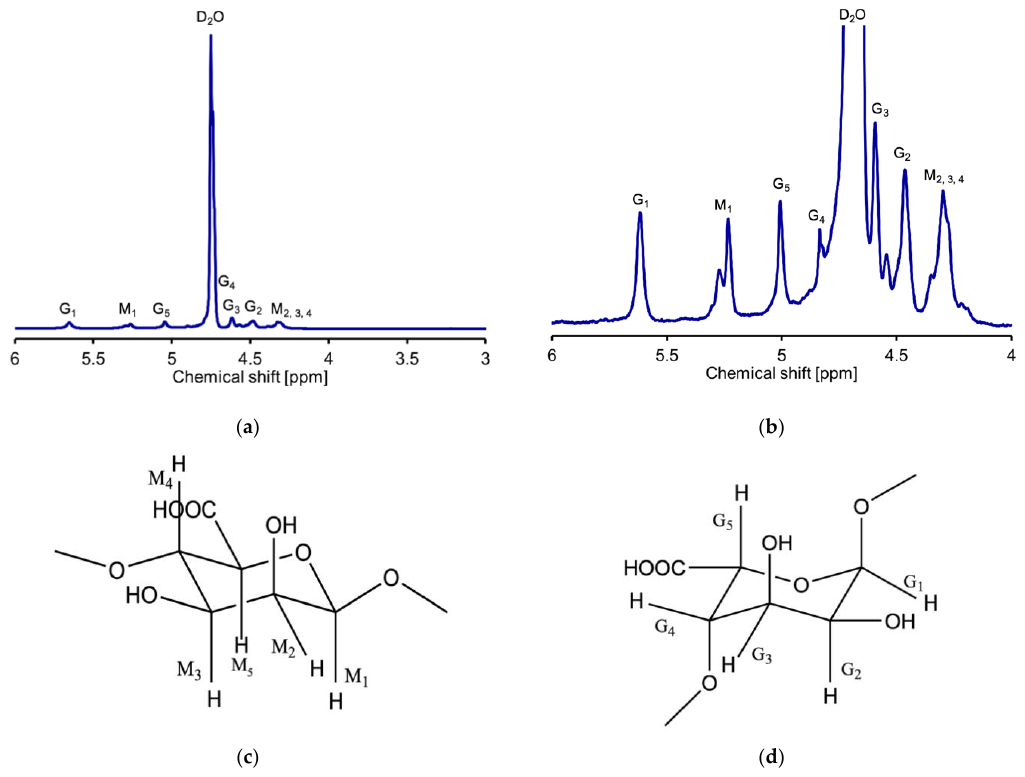
Figure 2. ( a ) 1 H-NMR spectra of sodium alginate from S. duplicatum ; ( b ) details of 1 H-NMR spectra; ( c ) structure of mannuronic acid; ( d ) structure of guluronic acid.